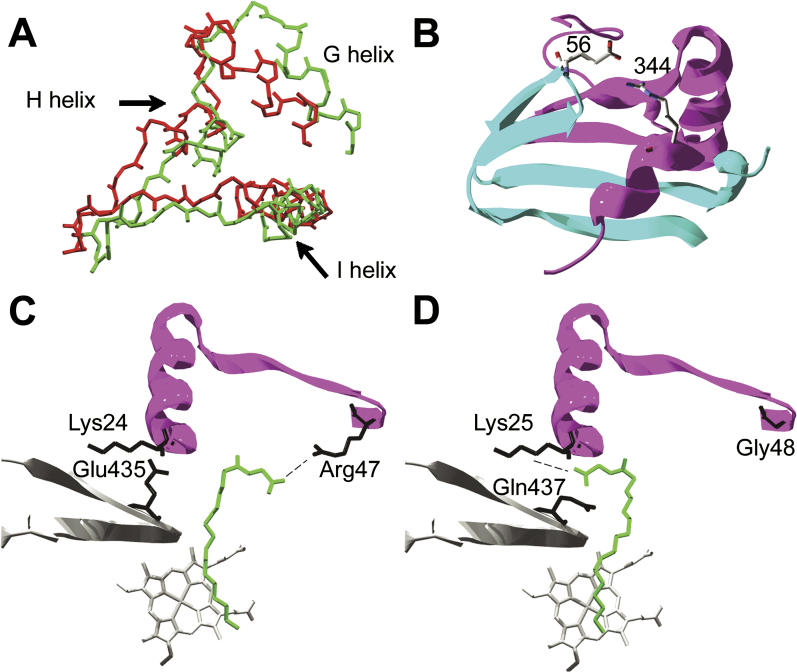
Structural Elements That Contribute Significantly to Proper Folding and Incorporation of Heme and Model of Substrate Binding in CYP102A1 and CYP102A2(A) Movement of block 5 between open (red) and closed (green) structural forms based on alignment of heme cofactor. The average displacement over the whole block is 3.6 Å.(B) Residues that could contribute to positively and negatively interacting fragments at blocks 1 and 7. Residue 56 (shown as arginine) is an arginine, glutamate, and glutamine; and residue 344 (shown as glutamate) is a glutamate, lysine, and glutamate in A1, A2, and A3, respectively. The fragment pairs that result in unfavorable charge–charge interactions for these closely spaced side chains are unfavorable overall for folding and heme incorporation.(C) In CYP102A1 the carboxylate group of the fatty acid substrate (in green) interacts with arginine 47 from block 1 (dashed line). Residue 435, from block 8, and residue 24 may form a salt bridge. Portions of blocks 1 and 8 are shown in purple and grey, respectively.(D) Proposed model for CYP102A2 showing an alternative binding configuration for the fatty acid substrate. Residue 437 (in block 8) is a glutamine in A2. Thus in A2, lysine 25 is free to interact with the substrate carboxylate group (dashed line). Structure shown is 1FAG [
29]. Amino acid residues are in black and heme is grey.